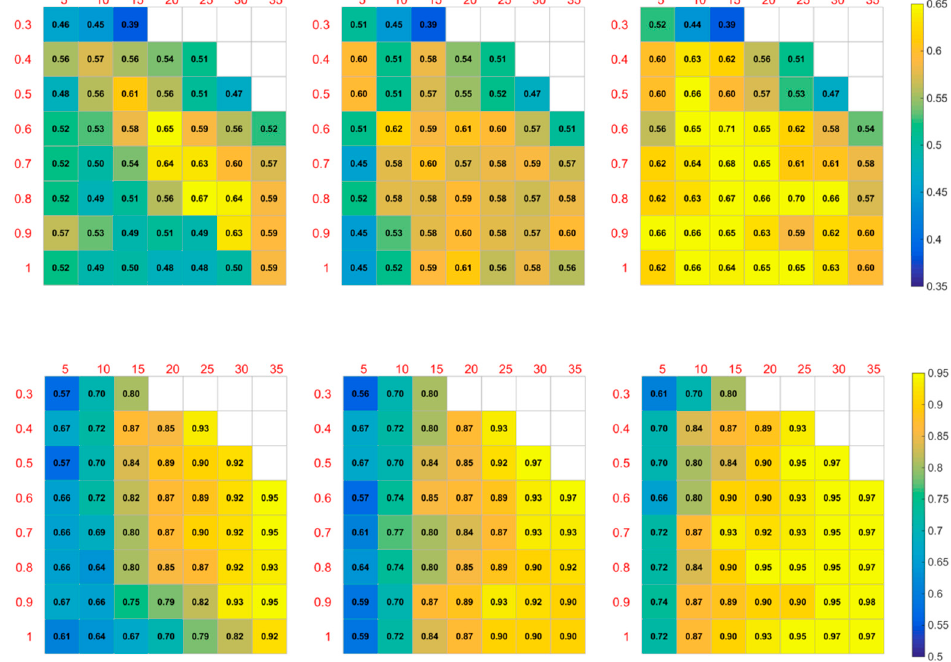
Figure 4. The repeated 10-fold CV scores ( upper panel ) and fitting scores ( lower panel ) for different C thrd s and N pre s, and predictor-selection schemes single-MLR ( left panel ), F-ratio ( middle panel ), and L1 ( right panel ).